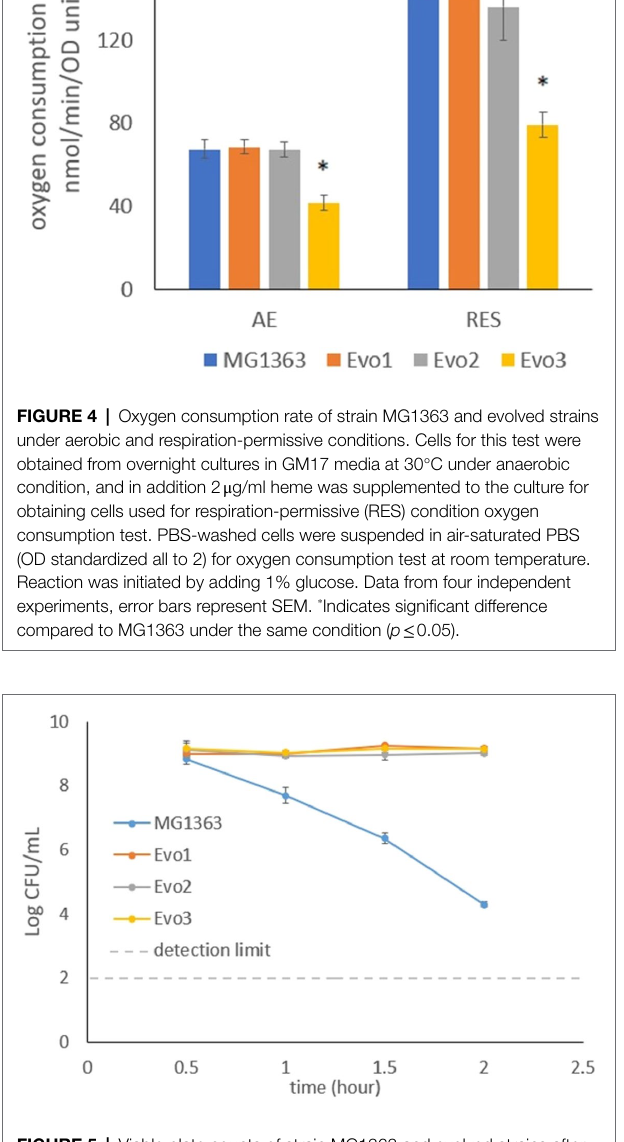
FIGURE 5 | Viable plate counts of strain MG1363 and evolved strains after exposure to 5 mM H 2 O 2 . Cells in the early exponential phase were treated with H 2 O 2 in GM17 media, incubated statically at 30 ° C. Data from biological triplicates, error bars represent SD.